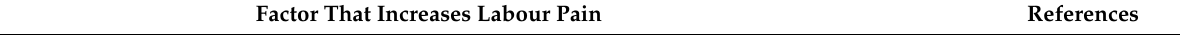
Table 3. Factors associated with dystocia, prolonged farrowing and pain in the sow. Factor That Increases Labour